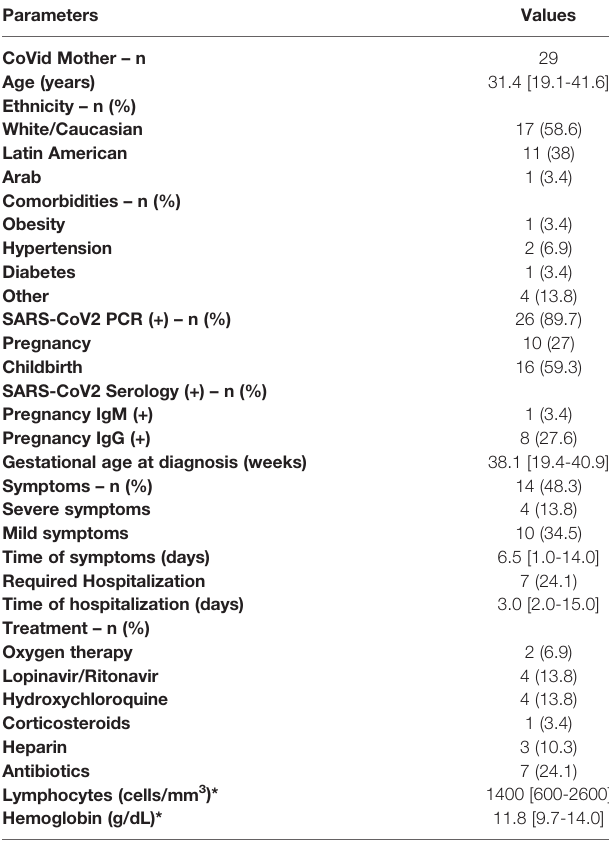
TABLE 1 | Infected SARS-CoV2 mothers ’